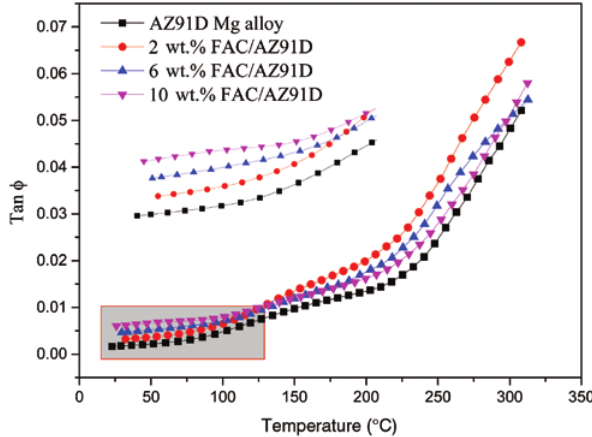
composites and AZ91D Mg alloy.